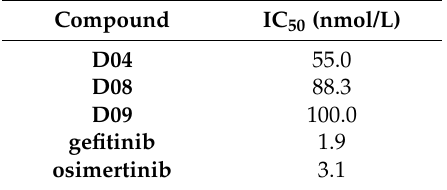
Table 3. Inhibitory activity (IC 50 , nmol/L) of EGFR